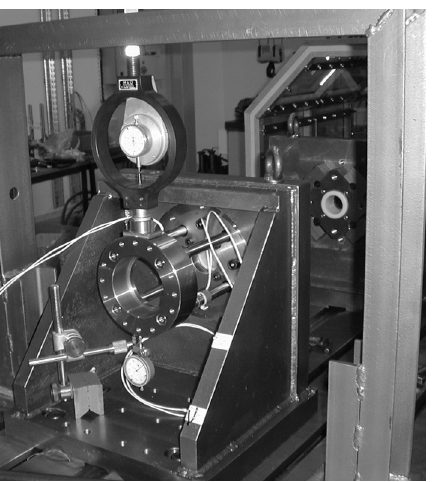
Figure 5: Estimation of the static sti ff ness versus the length L